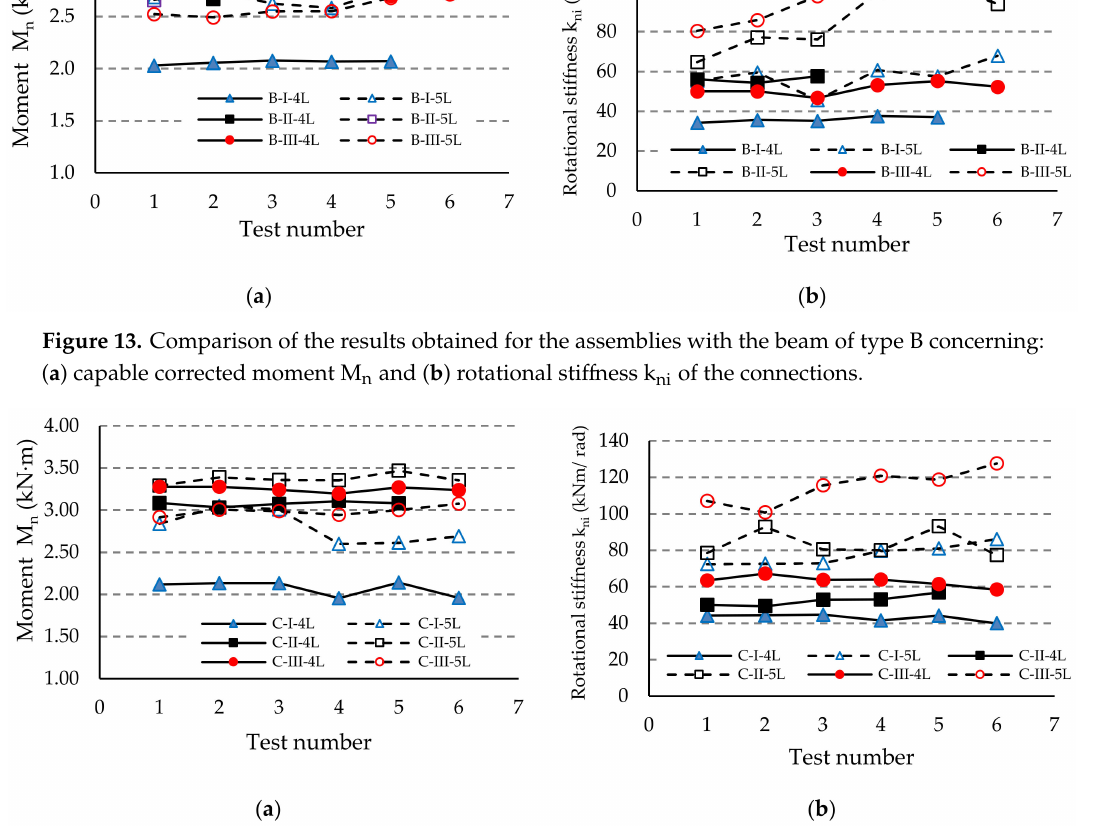
Figure 14. Comparison of the results obtained for the assemblies with the beam of type C concerning: ( a ) capable corrected moment M n , and ( b ) rotational sti ff ness k ni of the